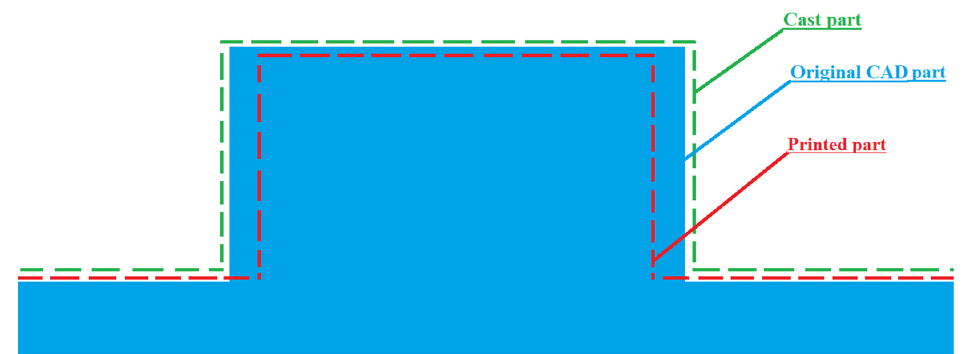
Figure 11. Deviations in the cast and printed